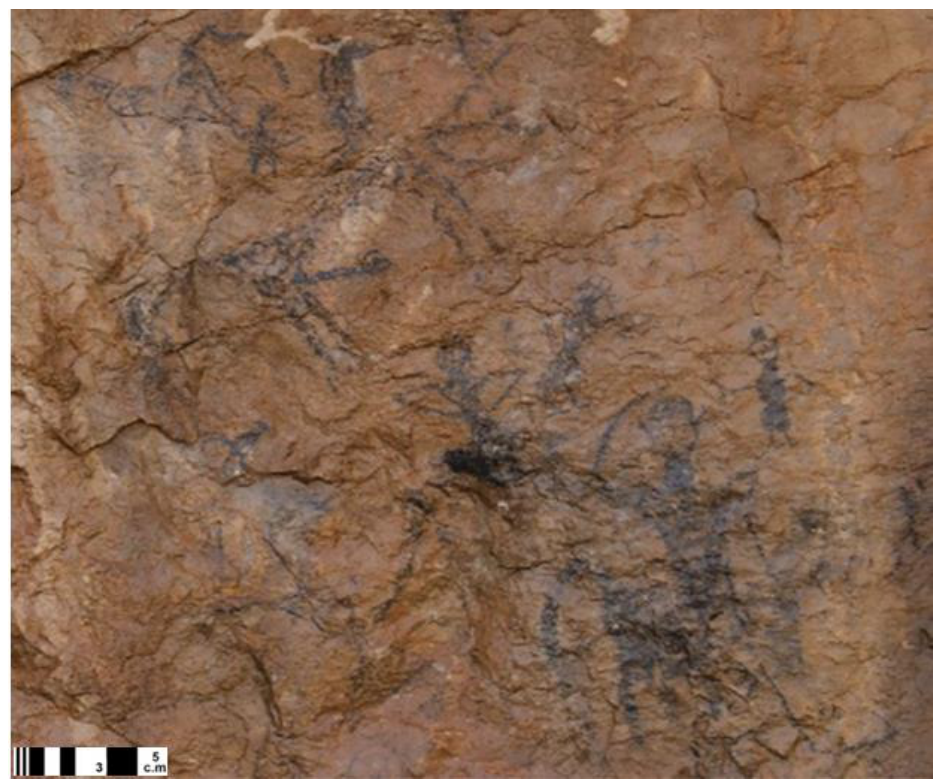
Figure 7. The main group of Pictograms in